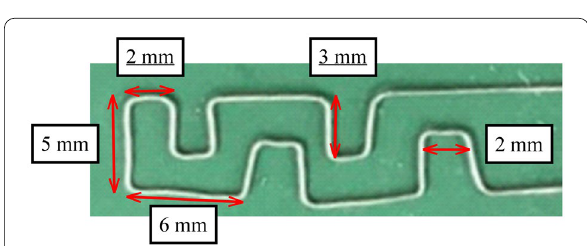
Fig. 3 Heating wire. The underlined lengths are smaller than those in our previous study